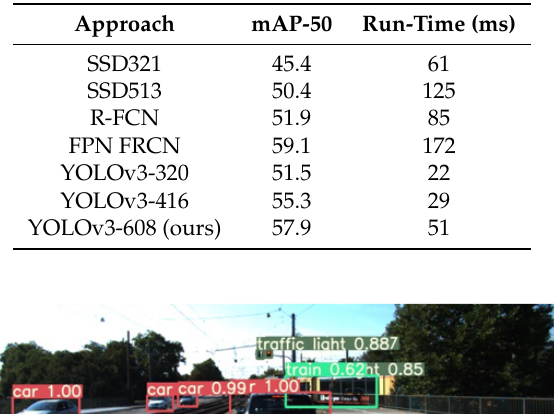
Table 2. Performance evaluation of our YOLOv3-based detector over a KITTI dataset against state-of-the-art approaches.